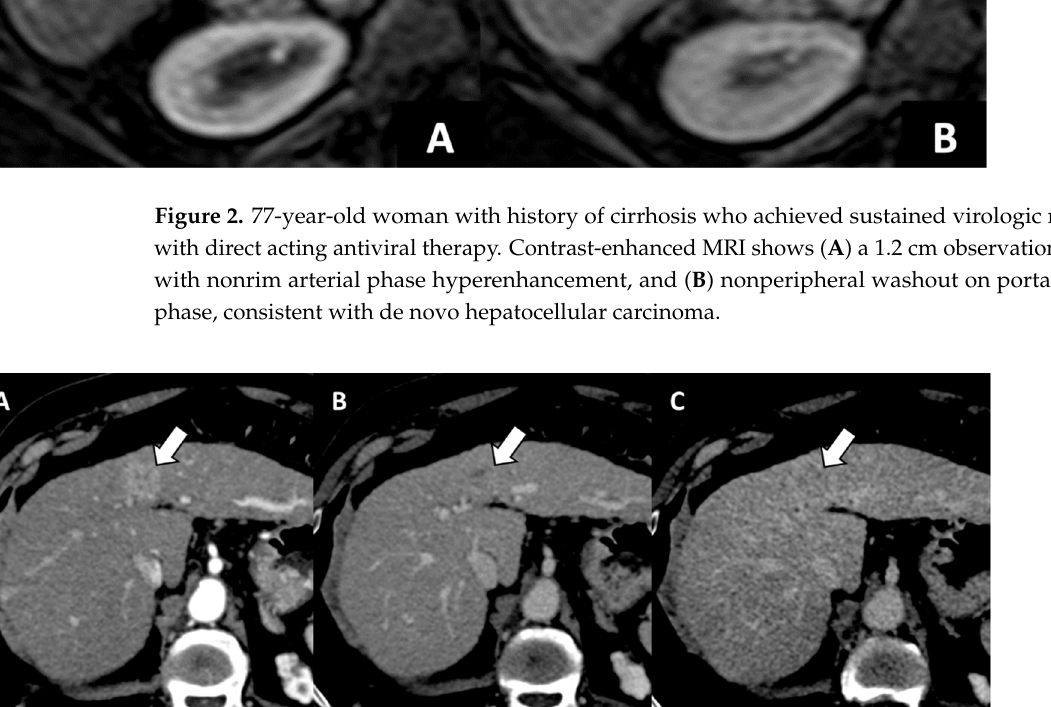
Figure 3. 71-year-old woman with cirrhosis who achieved sustained virologic response with direct acting antiviral therapy and history of HCC before HCV eradication. Contrast-enhanced CT reveals a 1.7 cm observation (arrow) nonrim arterial phase hyperenhancement ( A ), and nonperipheral washout (arrows) on portal venous ( B ) and delayed ( C ) phases, consistent with de novo hepatocellular carcinoma at 16 months after DAA.